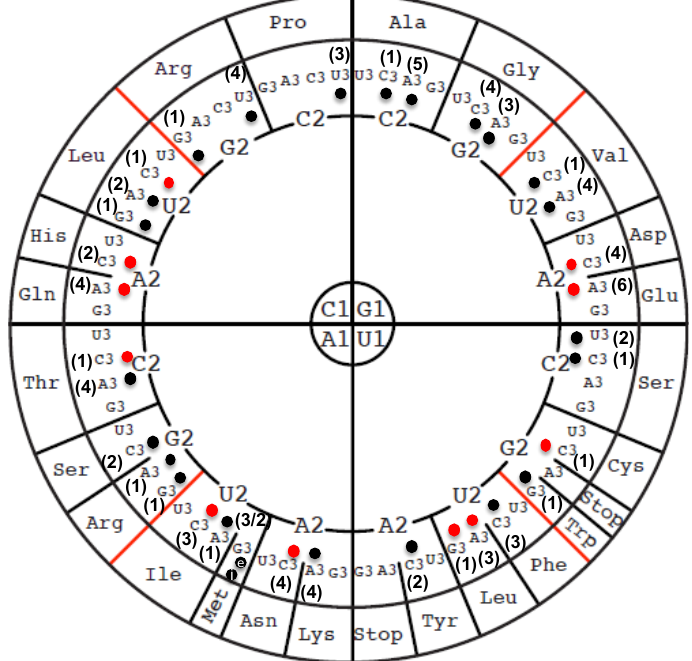
Figure 2. Compilation of sequenced B. subtilis tRNA genes and tRNA molecules. Circular representation of the genetic code displaying modified nucleosides based on Grosjean and Westhof [48]. The codon sequence of each amino acid is read in the inside-out direction (1-2-3). The numbers of isoforms are shown by the number in parentheses and the data were extracted from the GtRNA-db 2.0 [26]. A red dot specifies that the tRNA has not been sequenced, while a black dot specifies that the tRNA sequence is available based on the information available in Modomics [27]. The “e” and “i” specify the elongator or initiator tRNA Met CAU , respectively.